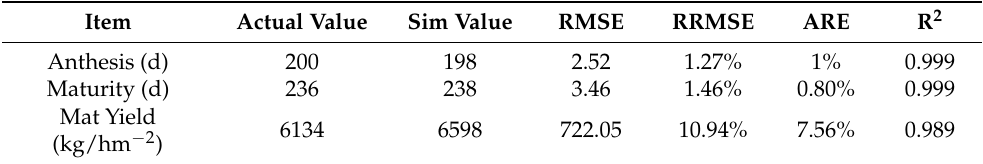
Table 6. Periodic simulation effect of the Xinji city winter wheat rate based on DSSAT (2015–2016).